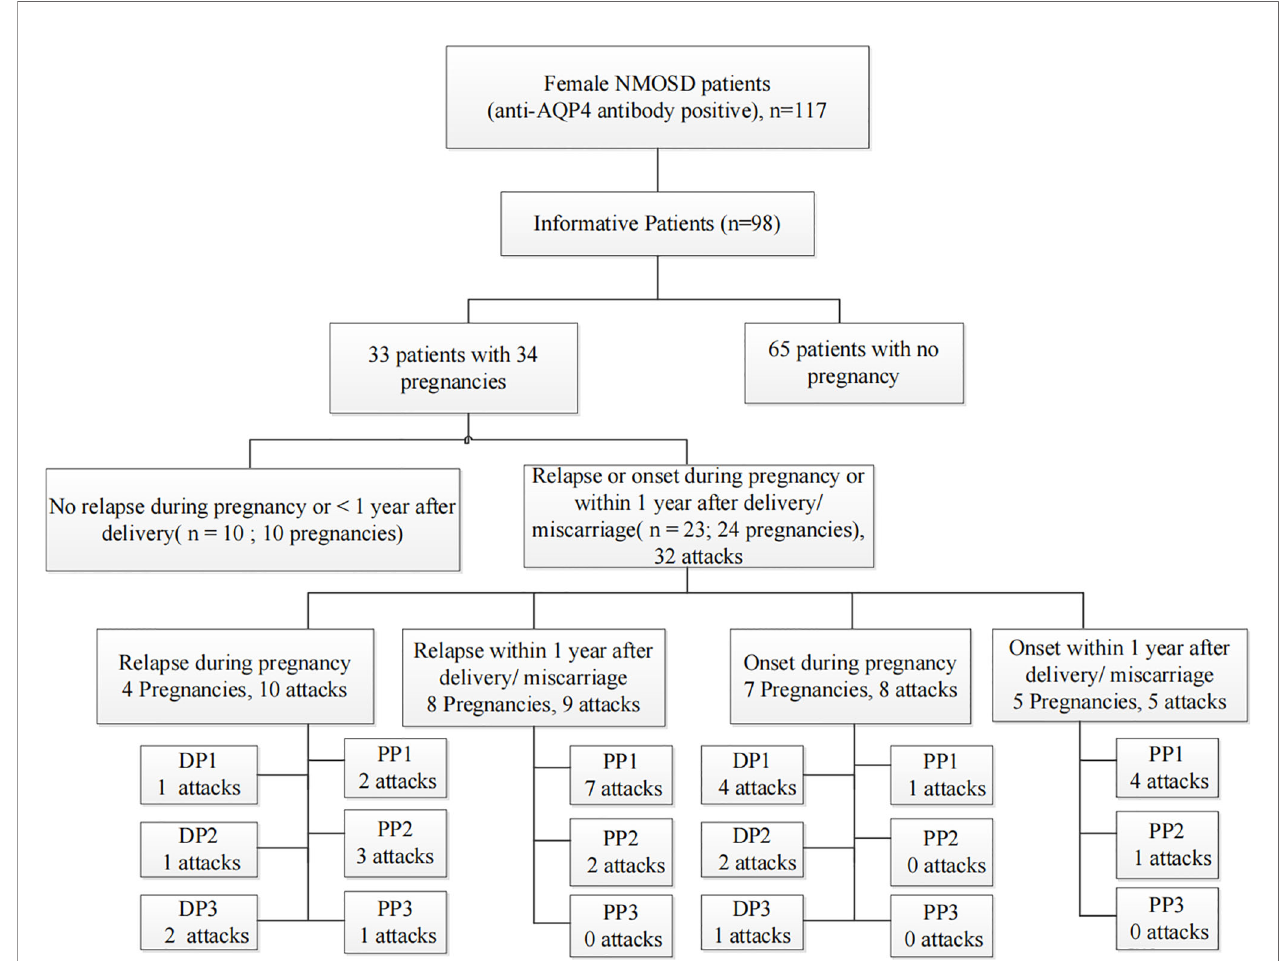
FIGURE 2 | Summative statistics by study population. An informative pregnancy was de fi ned as cases in which an attack occurred during pregnancy or within 1 year after delivery or abortion. DP, the period during pregnancy; DP1, during the fi rst trimester of pregnancy; DP2, during the second trimester of pregnancy; DP3, during the third trimester of pregnancy; PP, within 1 year of the postpartum period; PP1, the fi rst trimester of the postpartum period; PP2, the second trimester of the postpartum period; PP3, 7 – 12 months of the postpartum